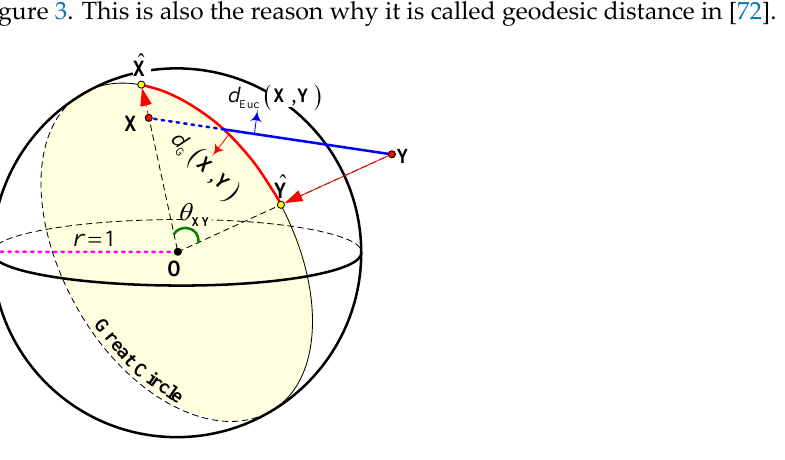
Figure 3. Illustration of cosine geodesic distance on unit sphere [13] and Euclidean distance. Specially, this geodesic distance is initially used to measure the difference between the observed PolSAR image data and some elementary scatters, i.e., the trihedral, dihedral, and ◦ 45 ‑rotated dihedral about the radar line of sight [72] So, this distance is useful to analyze the main scattering mechanisms of PolSAR image data. Moreover, it can also be directly used on the observed data of two PolSAR image pixels. manifold, we refer to it as the cosine geodesic distance (CGD) in this paper. It can be seen that the CGD focuses more on the difference between vector direction rather than in length. The CGD is scale‑invariant, since data angle or the data projections on the unit sphere are the same regardless of the change in the data power. Therefore, in [72], the CGD